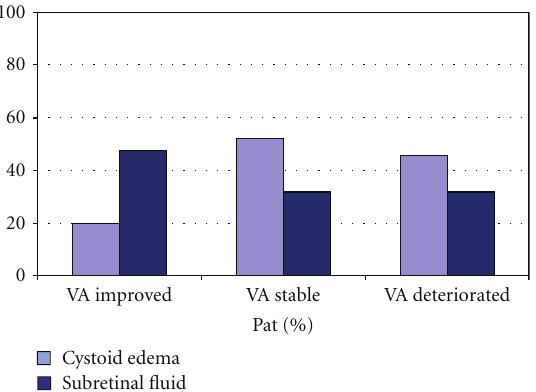
Figure 5: Percentage of patients displaying good continuity of external limiting membrane on baseline OCT and with either con- current intraretinal cystoid edema or subretinal fluid accumulation, in relation to the final visual